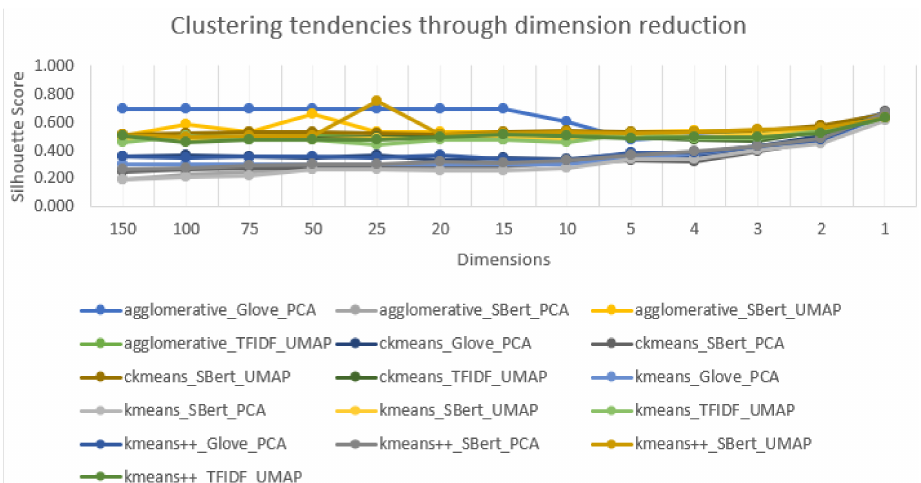
Figure 5. Clustering tendencies through dimension reduction on the baseball